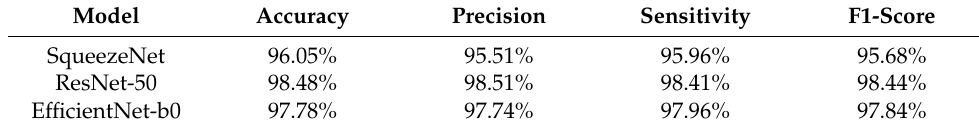
Table 2. Summary of key performance indicators (KPIs) for the proposed